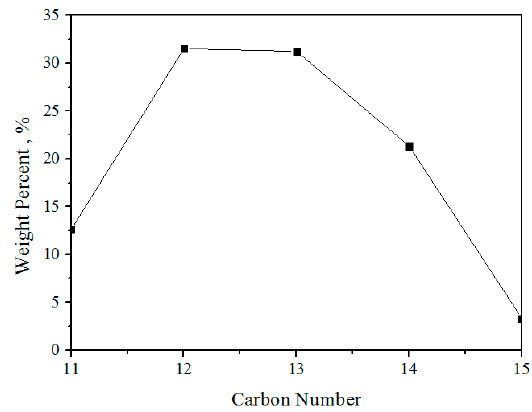
Figure 3. Carbon number distribution of artificial oil.